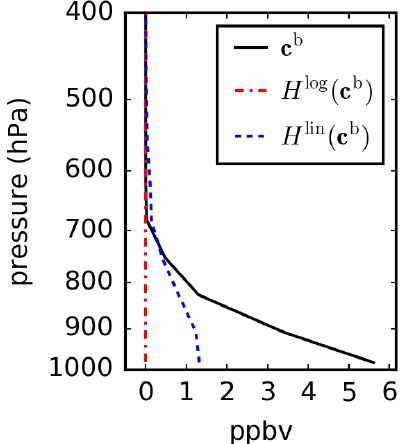
Figure 2. GEM-MACH profile at a retrieval location for the CrIS retrieval at 44.92 ◦ N, 92.96 ◦ W on 12 May 2016, 07:48:58UTC. Profiles are shown for the model ( c b ), as well as the profiles that result from applying the log-space ( H log ) and linear-space ( H lin ) observation